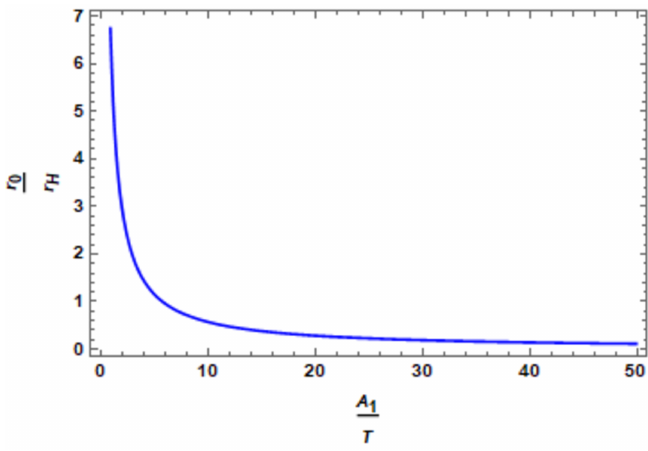
Figure 4. A pictorial representation that within the regime r 0 ∼ r H , A 1 /T (cid:29) 1 can be achieved for the class of numerical